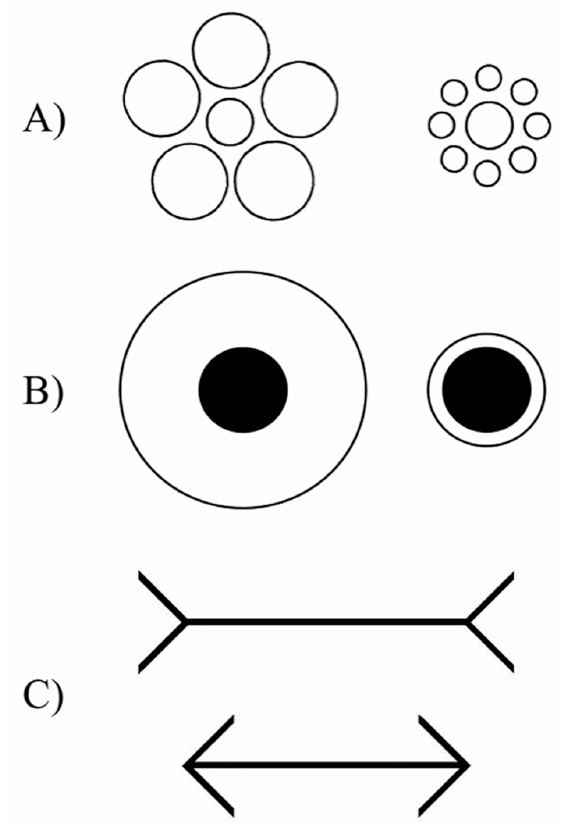
Figure 1. Notable size illusions: A ) Ebbinghaus illusion, B ) Delboeuf illusion, C) Müller-Lyer illusion.